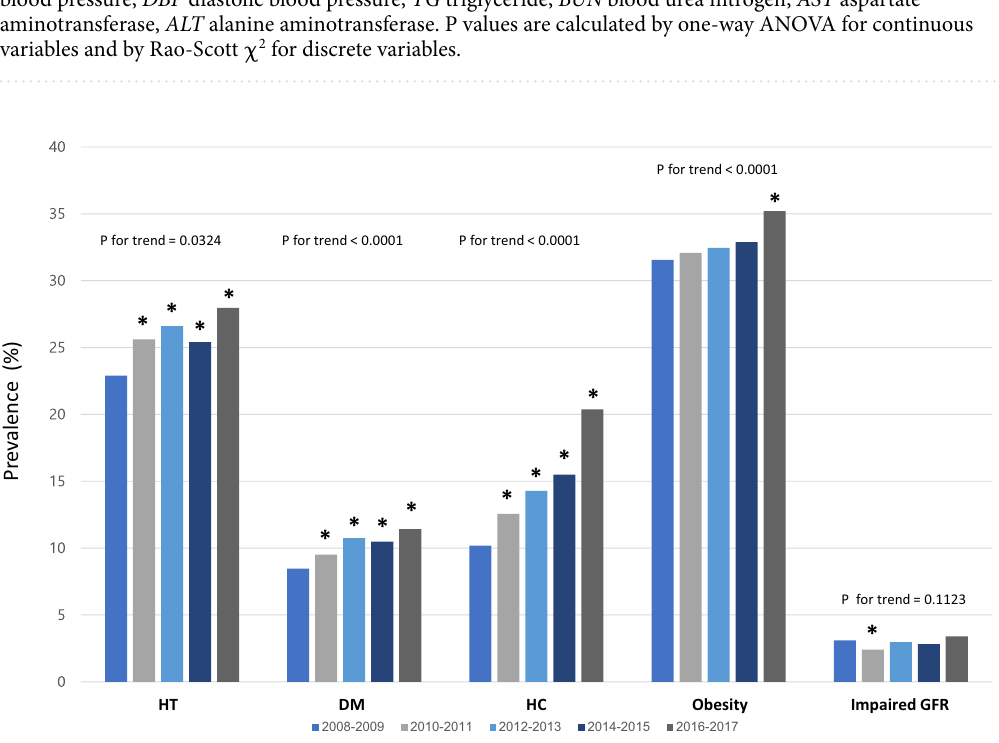
Figure 1. Trends of hypertension, diabetes mellitus, hypercholesterolemia, obesity, and impaired GFR prevalence from 2008 to 2017 in Korea. Prevalence of hypertension, diabetes mellitus, hypercholesterolemia, and obesity is significantly increased from 2008 to 2017. HT hypertension, DM diabetes mellitus, HC hypercholesterolemia, GFR glomerular filtration rate, *p < 0.05 compared with 2008–2009. Trend analysis was performed by regression analysis and age-adjusted P values are